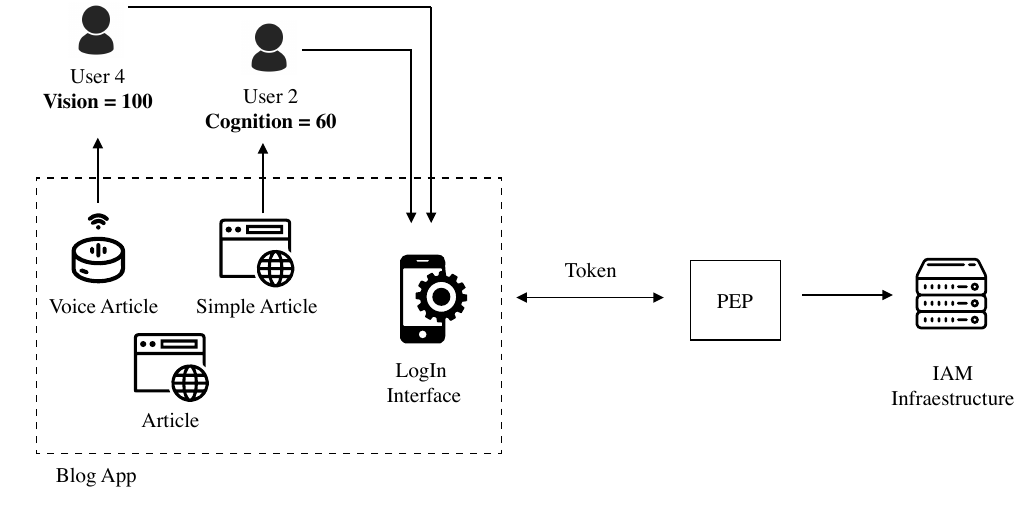
Figure 7. Use case